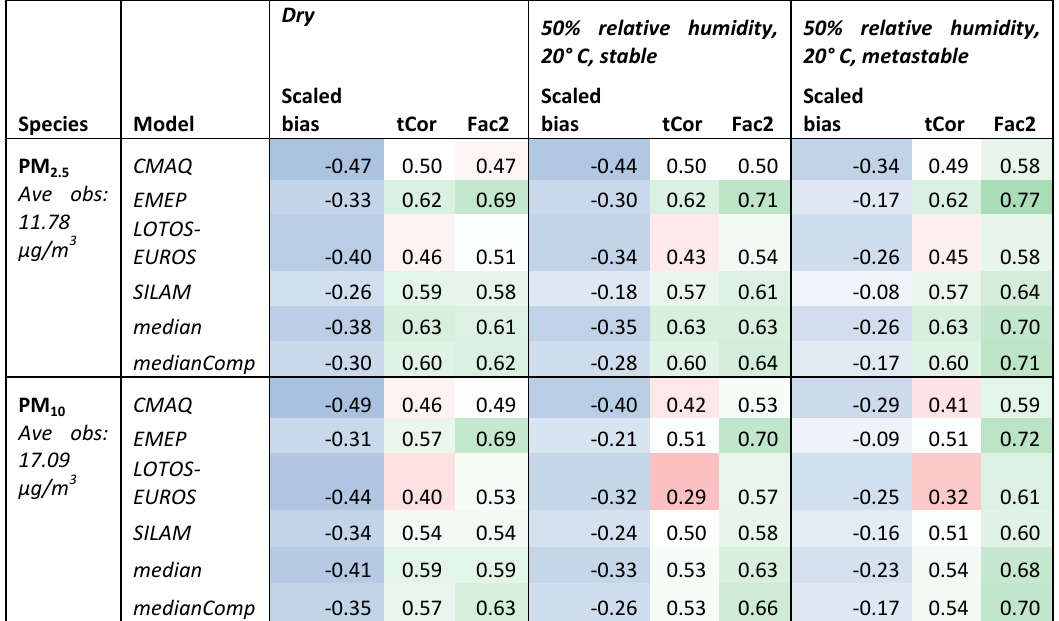
Table 6 Annual statistics for the PM 2.5 and PM 10 , dry mass, aerosol bound water added assuming stable state (lower curve of the hysteresis loop) and metastable state (higher curve of the hysteresis loop). ScaledBias - bias divided with the mean observed value, tCor - temporal correlation of the daily values, Fac2 – the fraction of daily values within factor of two from the observed ones. The shading emphasizes the range of the